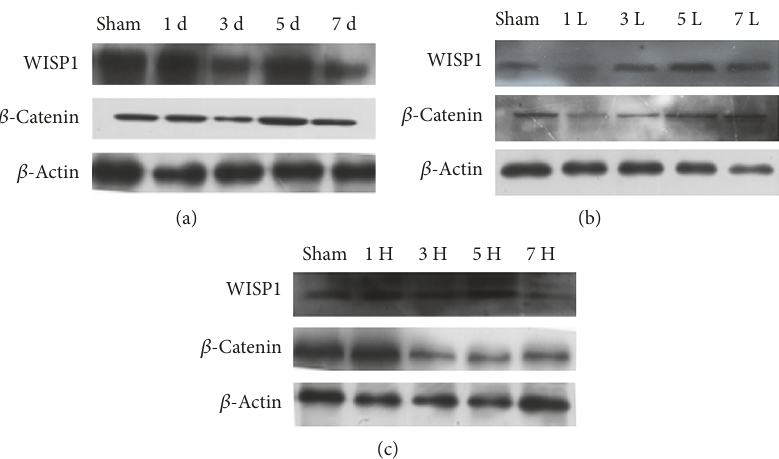
Figure 7: WISP1 and β -catenin protein expression ( P < 0 05 , P < 0 01 ). Sham: sham group; 1 d: ipsilateral 1d post-TBI group; 3 d: ipsilateral 3d post-TBI group; 5d: ipsilateral 5 d post-TBI group; 7d: ipsilateral 7 d post-TBI group; 1L: 1 d post-TBI+ 1mM PQQ group; 3 L: 3 d post-TBI+1 mM PQQ group; 5L: 5d post-TBI+ 1mM PQQ group; 7 L: 7d post-TBI +1mM PQQ group; 1 H: 1 d post-TBI+2 mM PQQ group; 3 H: 3d post-TBI+ 2mM PQQ group; 5H: 5d post-TBI+ 2mM PQQ group; 7H: 7d post-TBI+2 mM PQQ group.